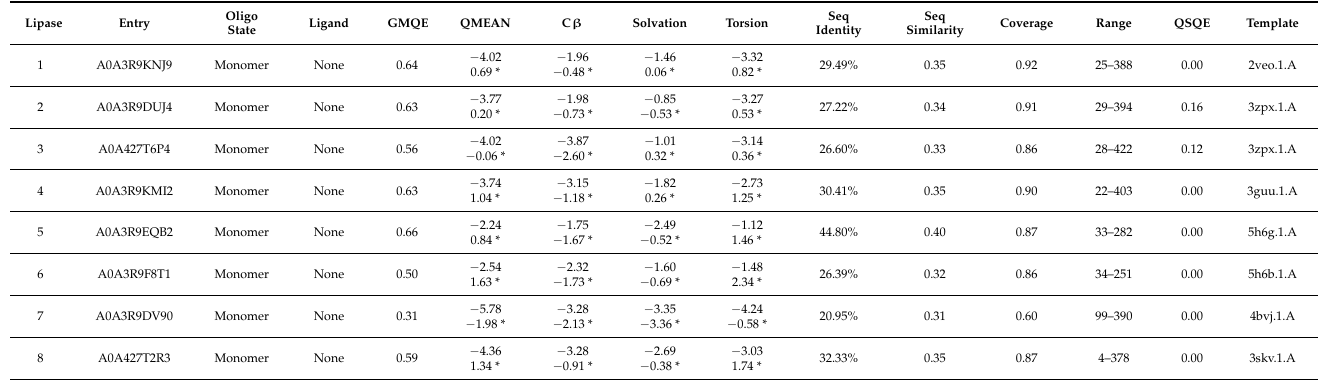
Figure 1. Lipase topology diagram with the strands indicated by arrow and helices by cylinder ( A ) Surface model representation of Amycolatopsis eburnea lipase 1 alone. (i) total SASA (ii) and Structurally conserved SASA in red (iii) ( B ) Amycolatopsis eburnea lipases modelled with deep learning de novo ( C ) (structurally conserved SASA in red, ribbon representation of lipases structures in blue). Table 2. Lipase Models properties were predicated for homology modeling and deep learning de novo. The properties for deep learning de novo are shown with *.